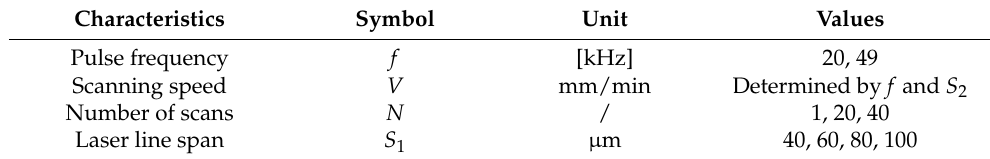
Table 3. Laser processing parameters.